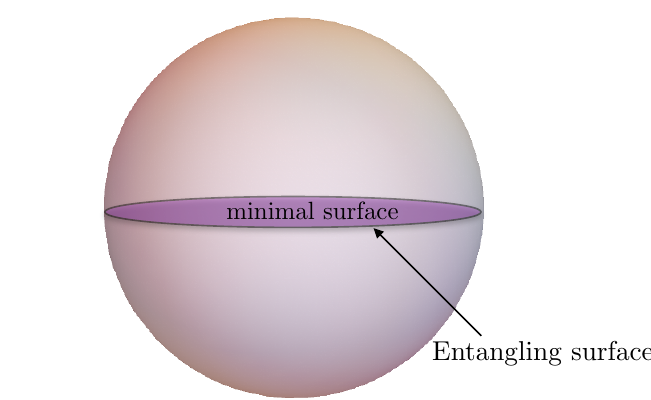
Figure 9. Sketch of the minimal surface which has the spherical surface (cid:18) = (cid:25)= 2 as its